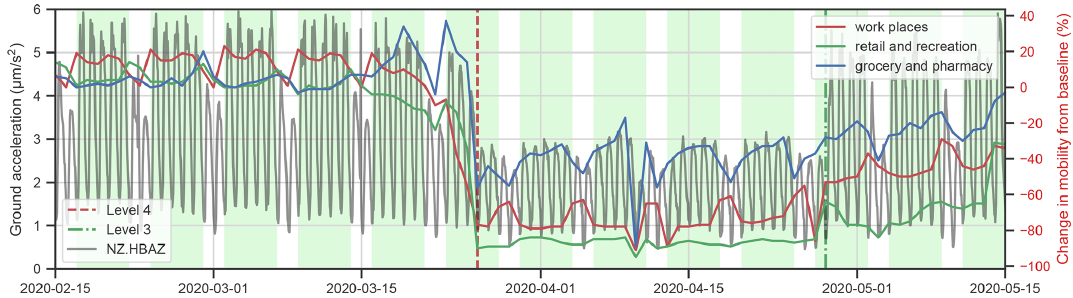
Figure 8. RSAM values for station HBAZ, compared to Google’s mobility data for Auckland.